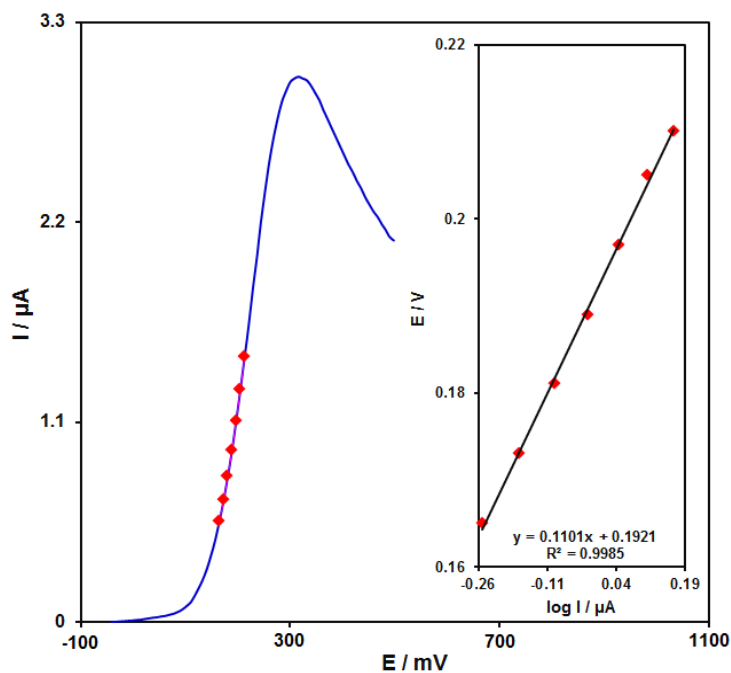
Figure 9. Linear sweep voltammograms at the GO/ZIF-67/SPE in 0.1 M PBS at pH equal to 7.0 with 100.0 μ M epinine at a scan rate of 10 mV s − 1 . These points stand for the output utilized in the Tafel plot. As seen, the inset represnts the Tafel plot derived from the linear sweep voltammogram.